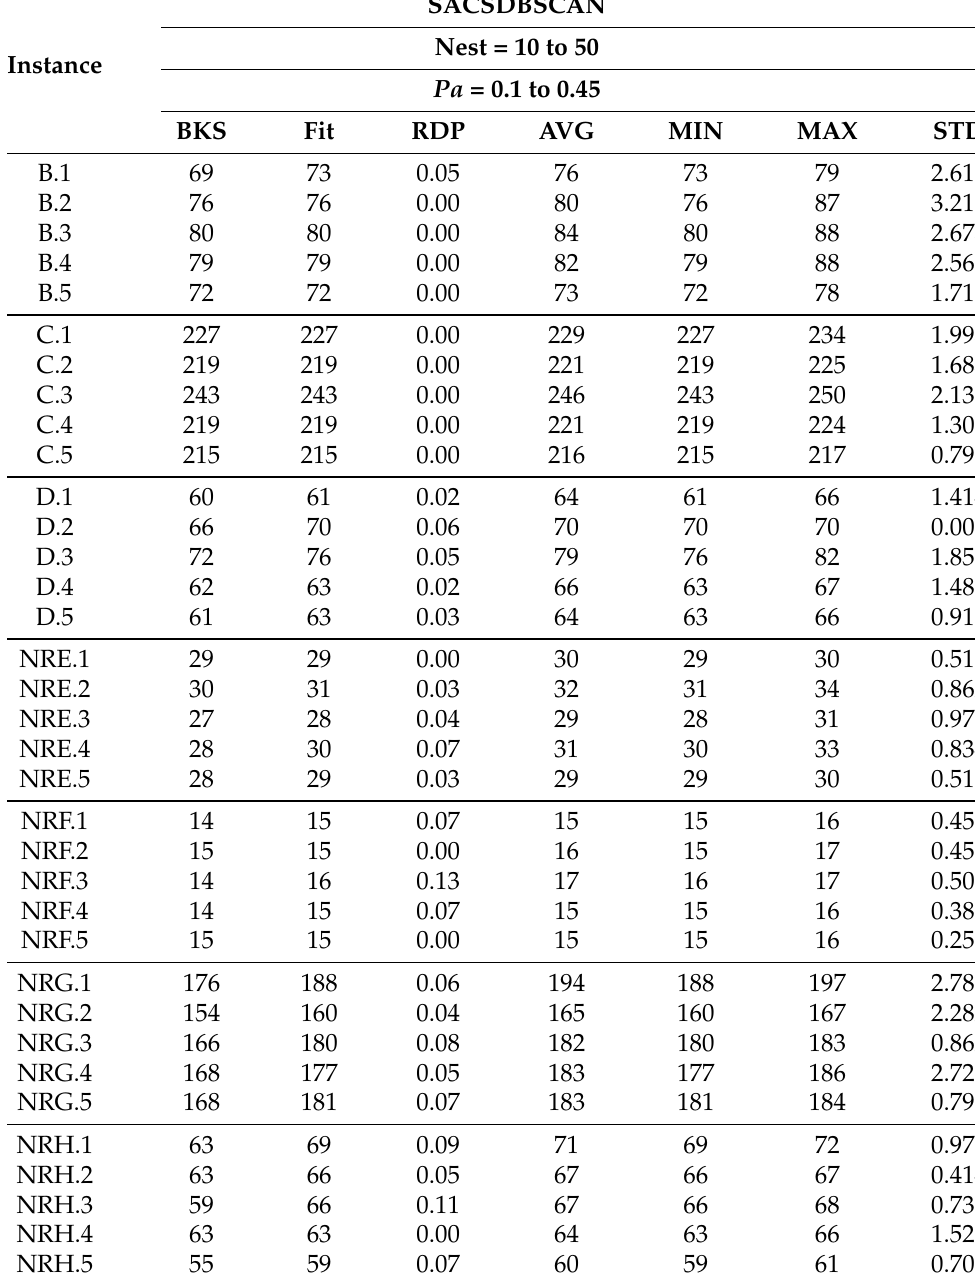
Table 4. Results of SACSDBSCAN for instance B, C, D, NRE, NRF, NRG and